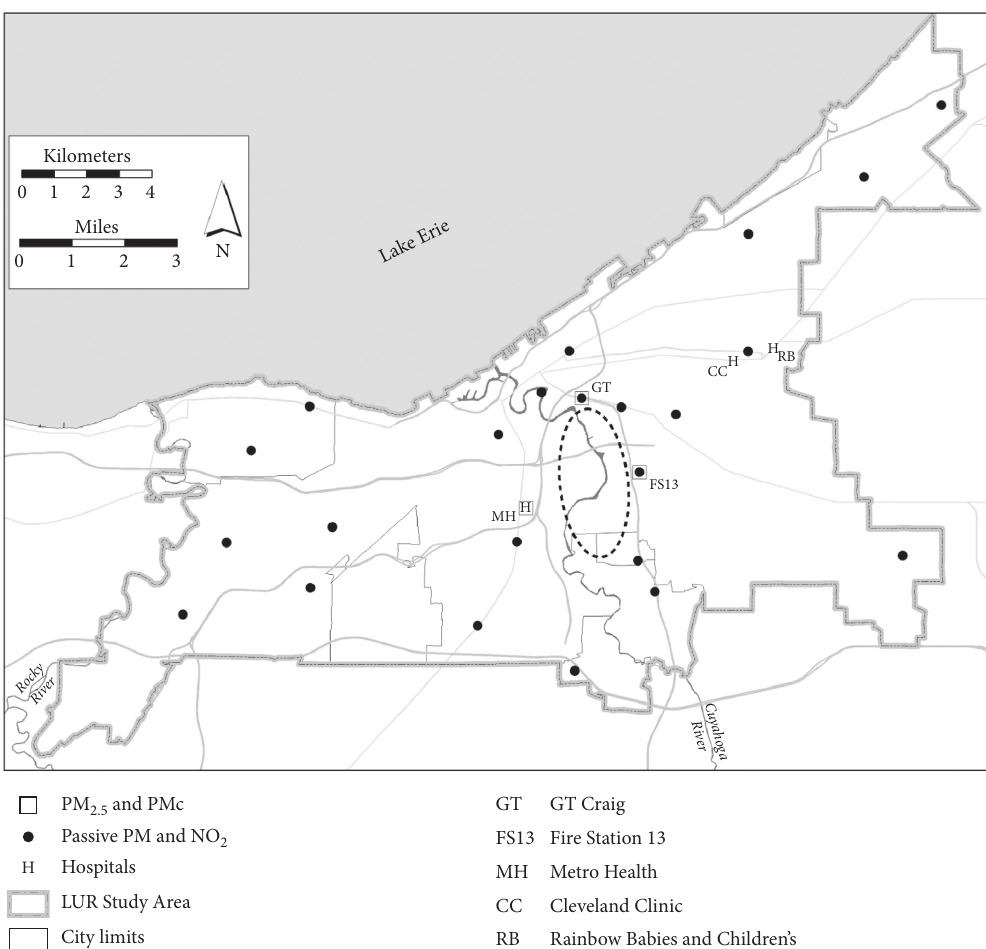
Figure 1: Locations of participating Cleveland hospitals (CC � Cleveland Clinic, RB � University Hospitals Rainbow Babies, and MH � Metro Health), monitoring sites, and the industrial valley located within the dashed